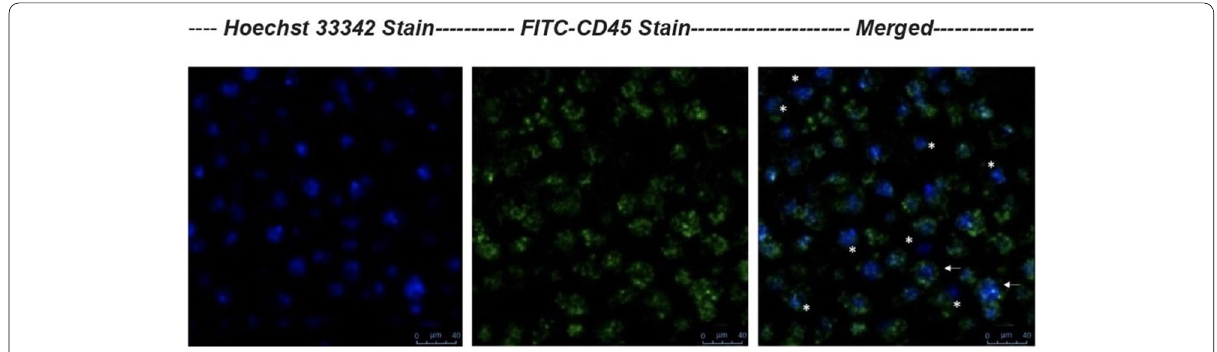
Fig. 3 Representative immunofluorescence images of PB‑NHESC‑C. Legend: Sample of the PB‑NHESC‑C were stained with FITC‑conjugated monoclonal surface antibody CD45 (1:100) and Hoechst nucleic acid dye 33,342 (10 μg/ml). Images were acquired using a Leica SP8